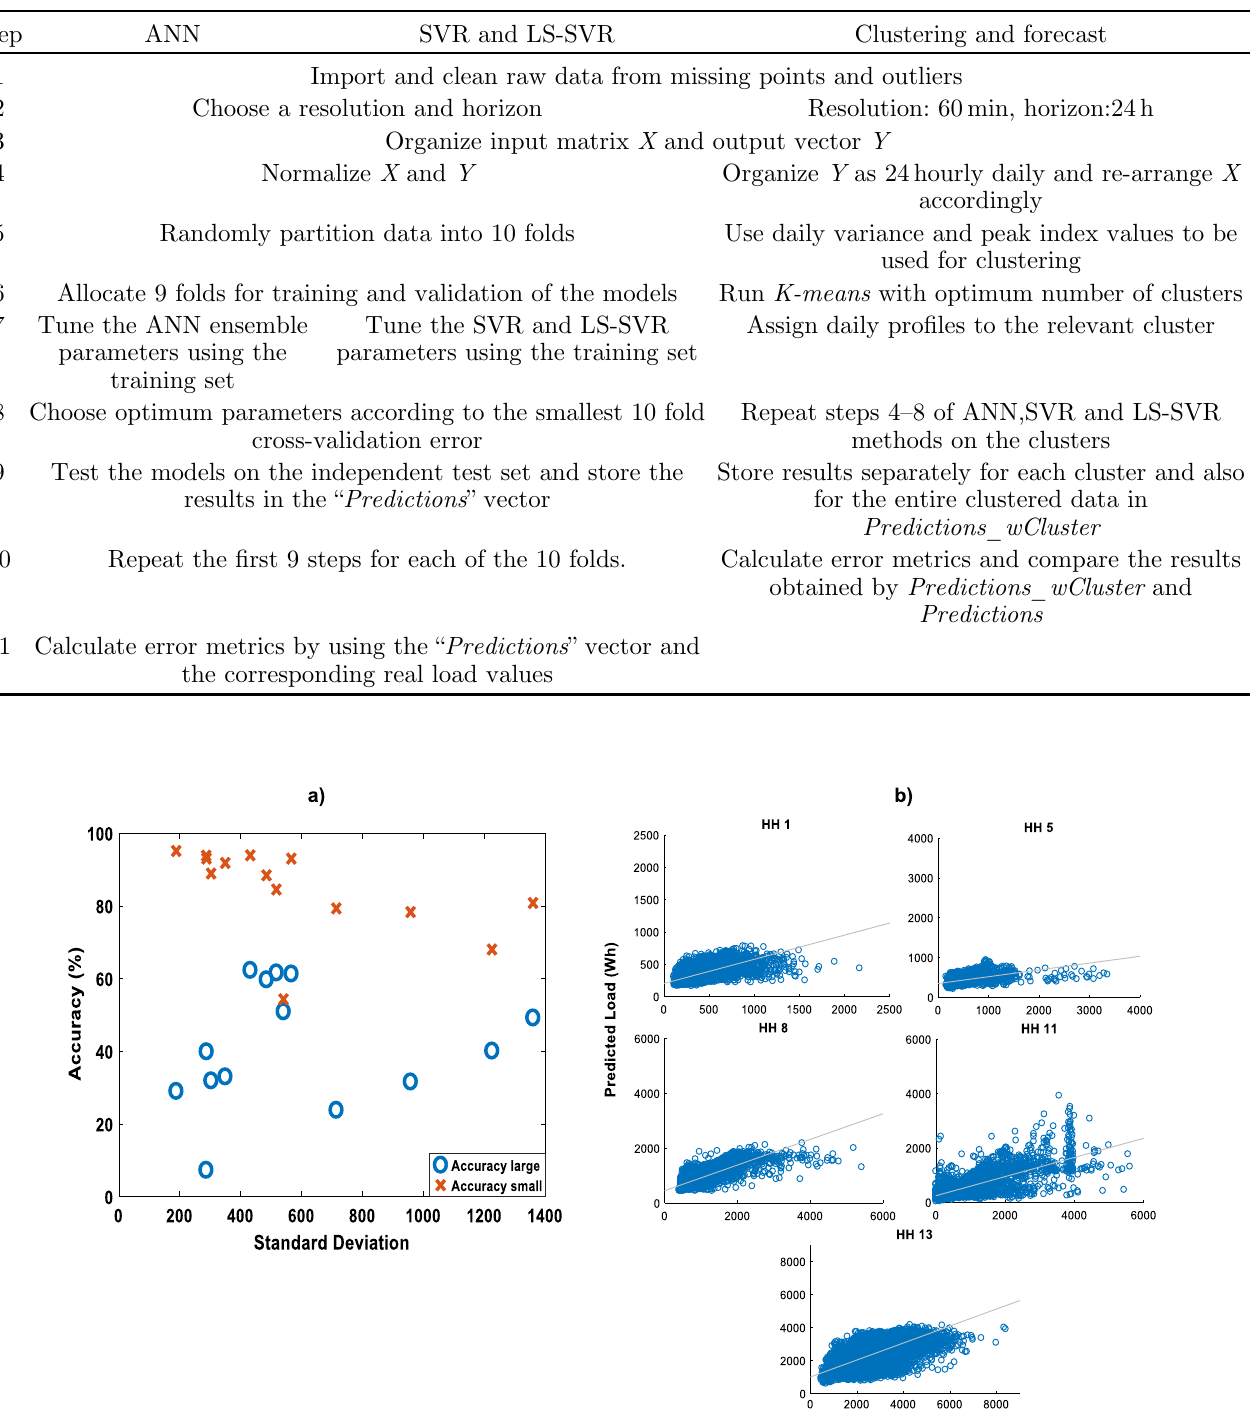
Table 1. Summary of the methodology used for the forecasting and clustering